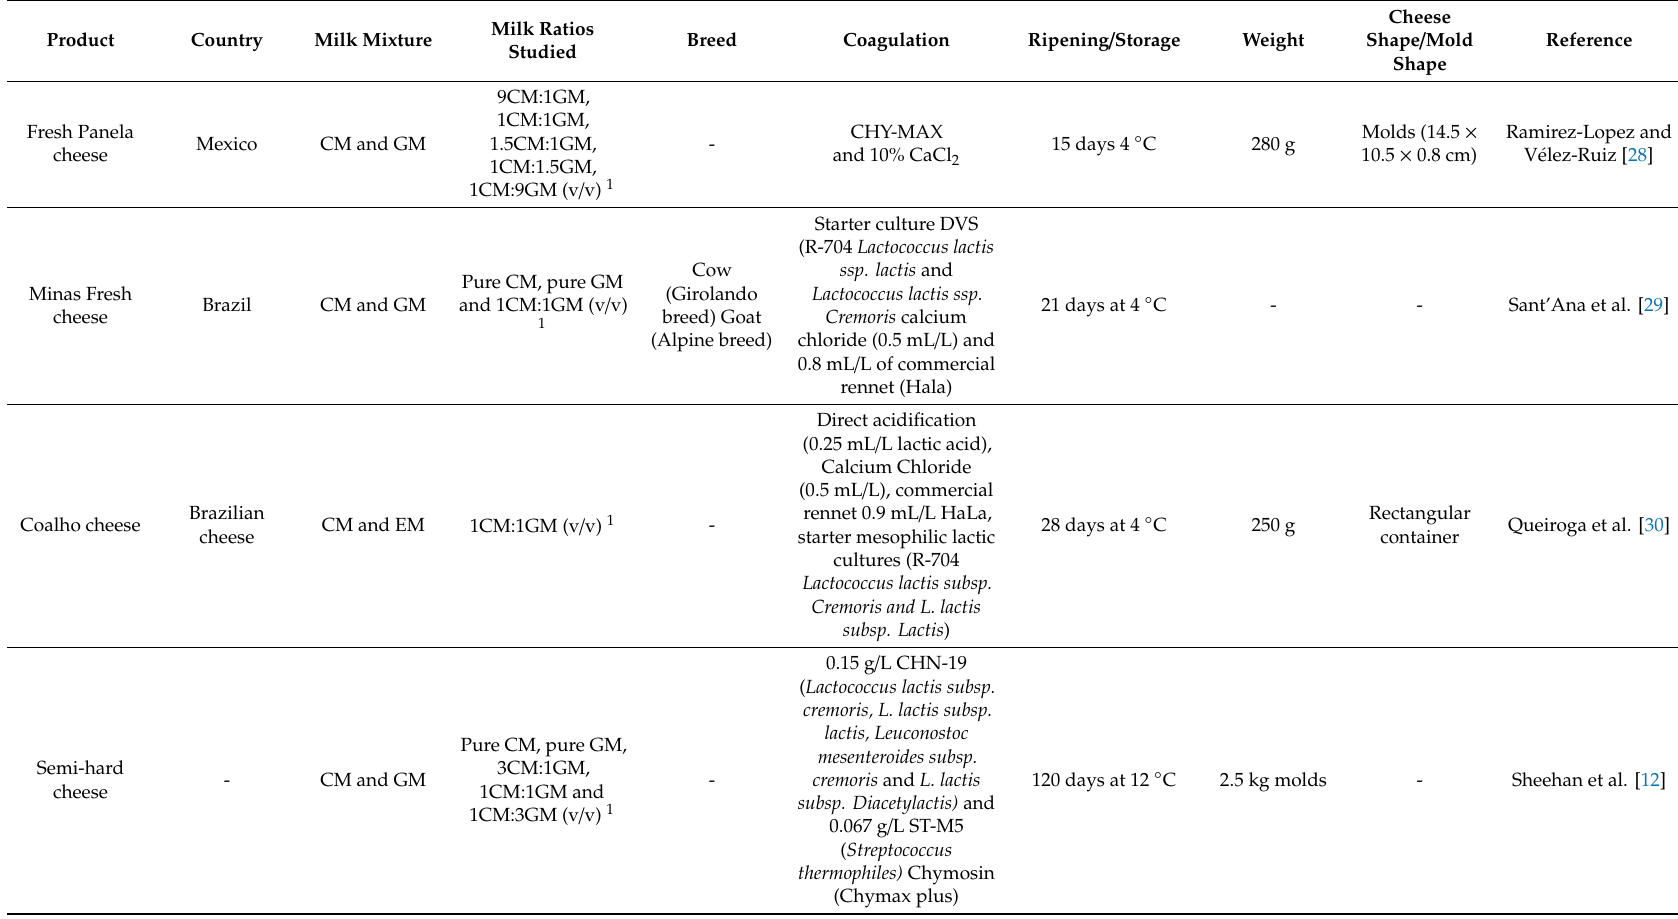
Table 1. A summary overview of the di ff erent studies conducted on cheeses 1